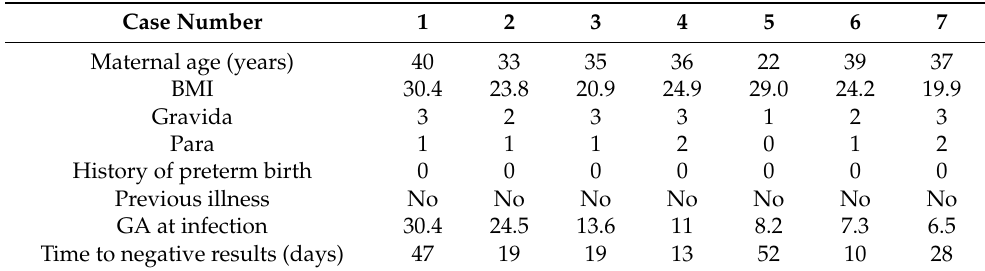
Table 1. Clinical characteristics.